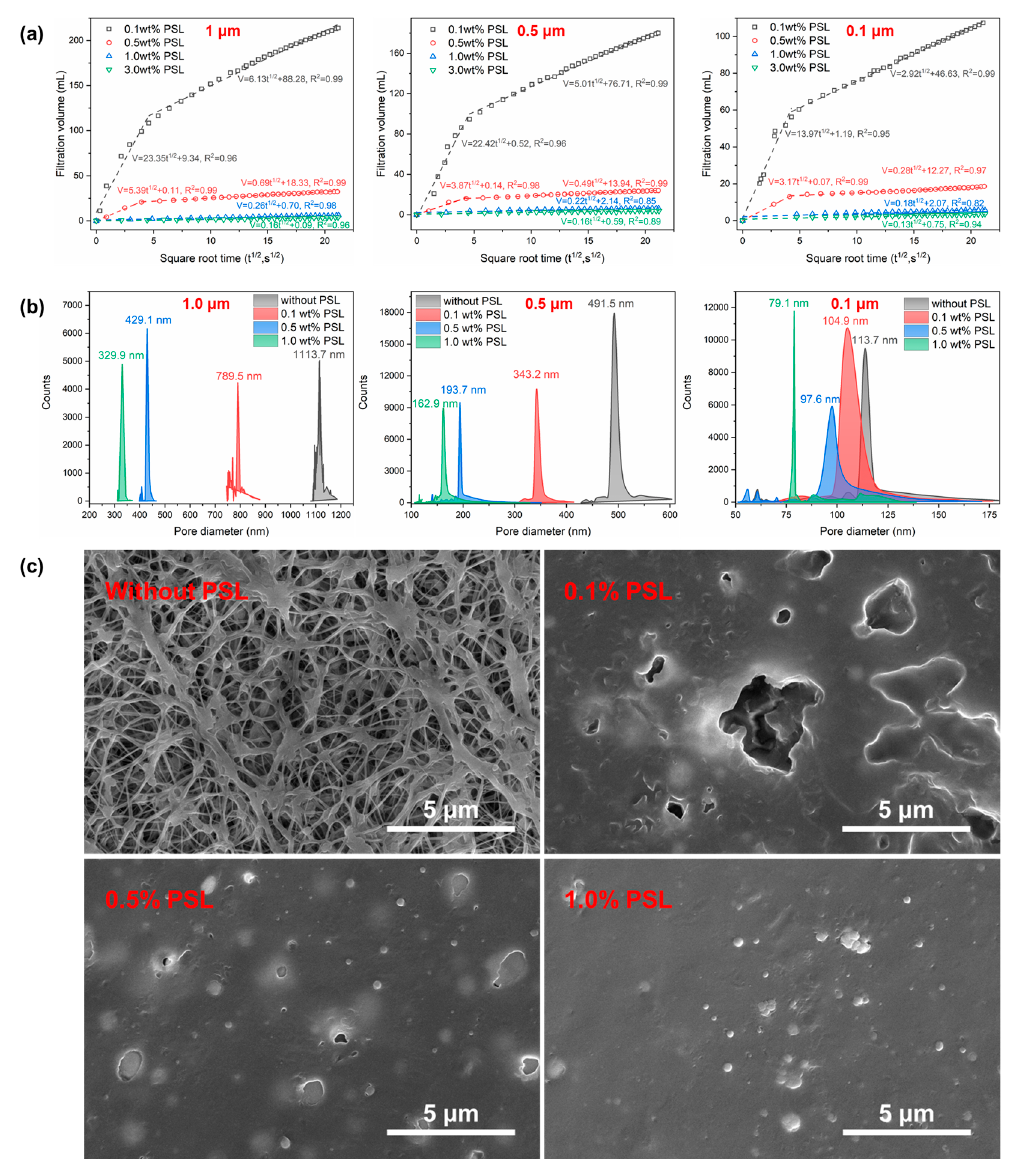
Figure 6. ( a )The static filtration volume of W/O emulsion with different concentrations of PSL rubber nanogels as a function of square root of time, ( b ) the pore diameter distribution of the different polytetrafluoroethylene membrane after the filtration test, ( c ) SEM images of the polytetrafluoroethylene membrane (1.0 μ m) after the filtration test. The magnification is 13,000 times.